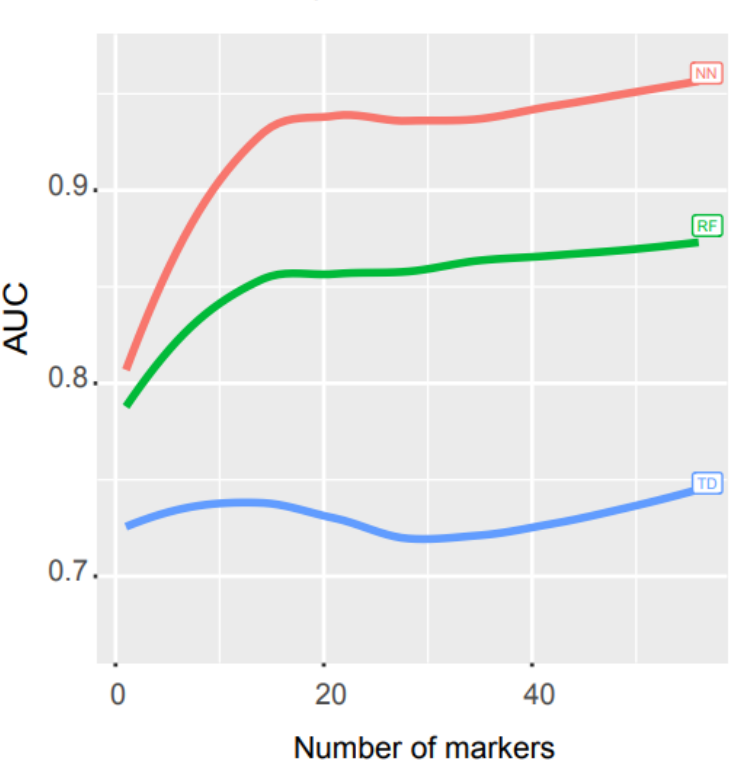
Figure 4. Math model comparisons. AUC comparison of three math models, artificial neural network (NN), random forest (RF), and decision trees (TD). NN outperformed the other two models.